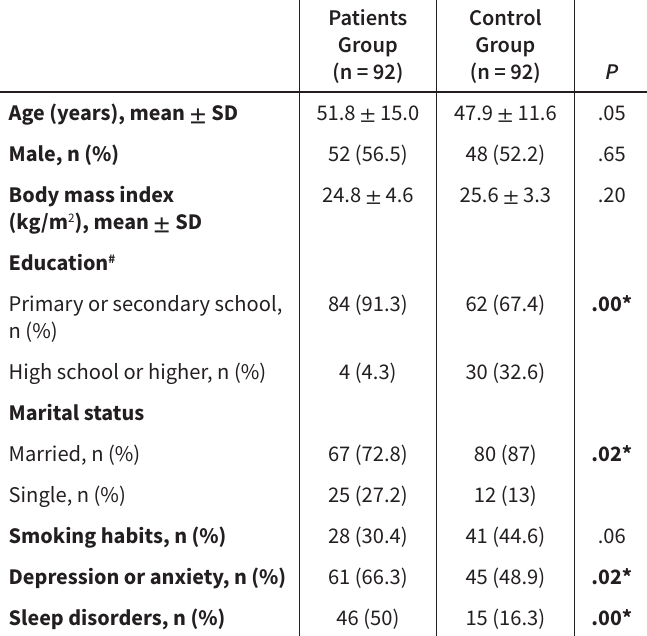
Table 3. Comparison of Temporomandibular Joint Disorders Between Patients and Control